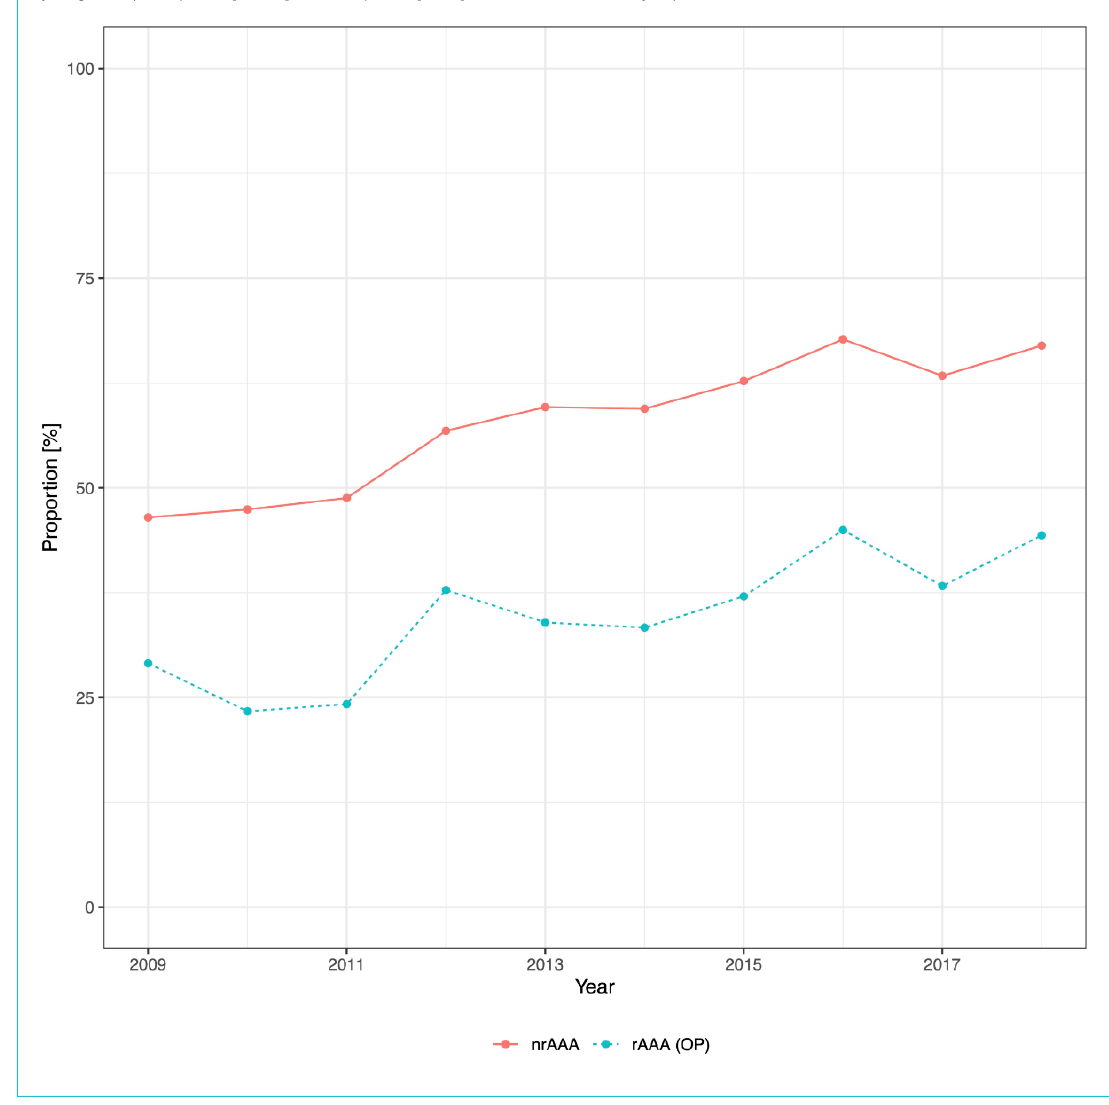
Figure 3: Proportion of patients with endovascular aortic repair (EVAR). The proportion of patients treated with EVAR for each year stratified by diagnosis (nonruptured [nrAAA] versus ruptured [rAAA] abdominal aortic